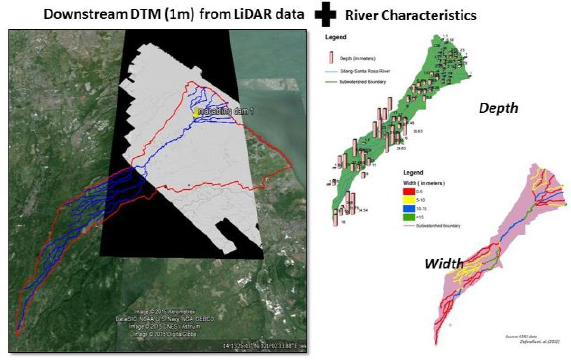
Figure 8. Input terrain and tributaries